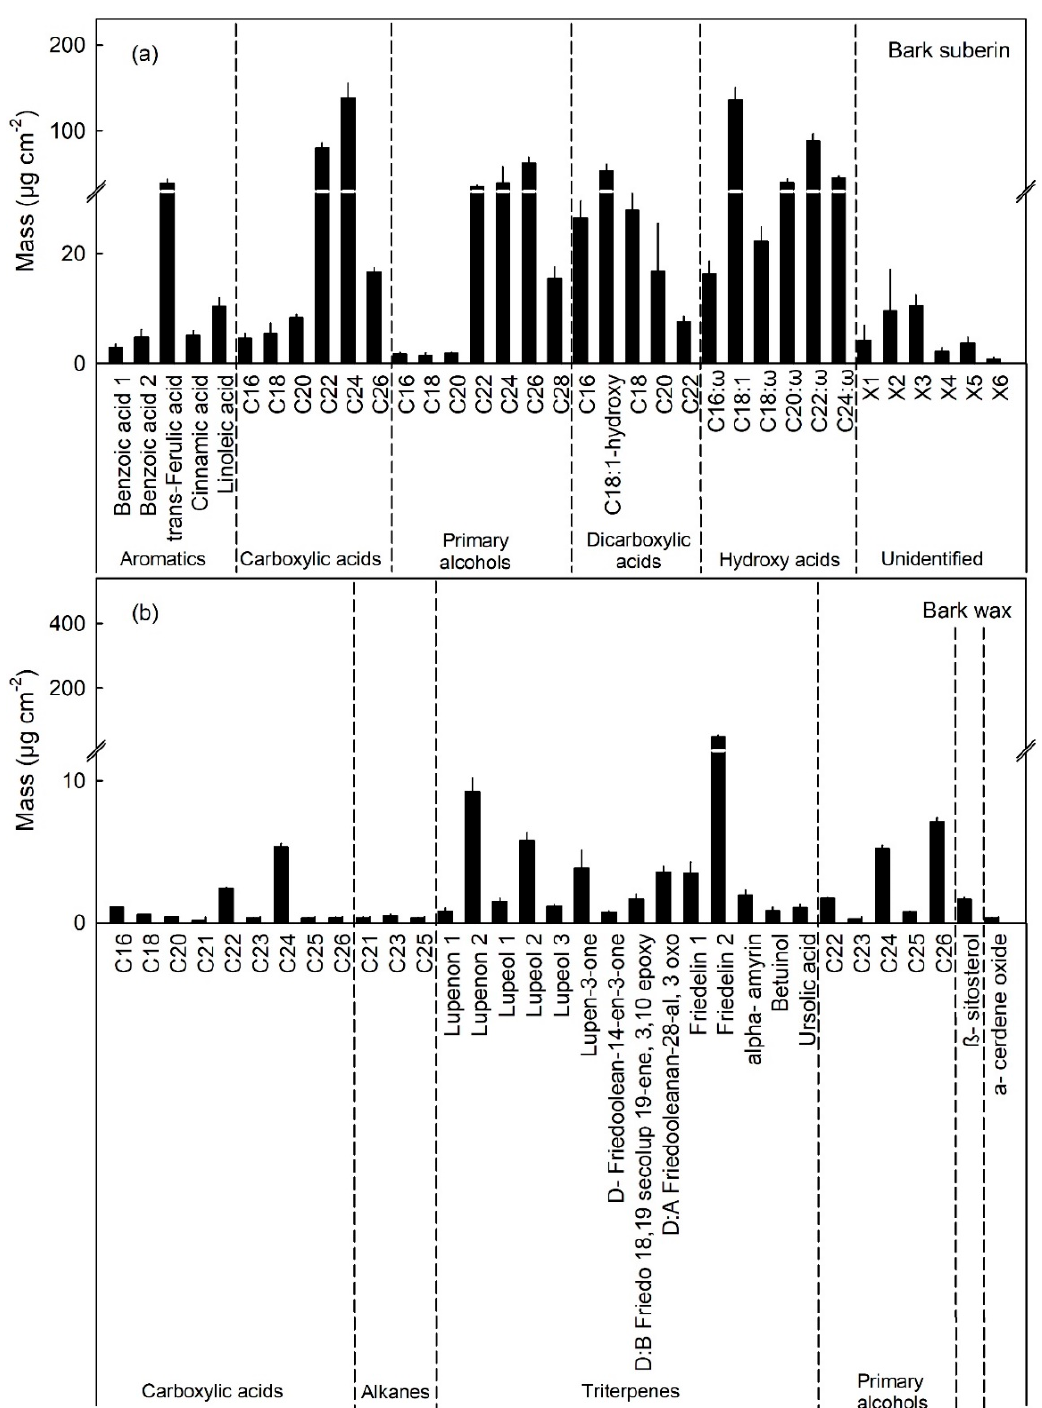
Figure 7. Composition of the periderm of the bark of the trunk (BP) of a ‘Pinova’ apple tree. ( a ) Constituents of the suberin and ( b ) constituents of the wax. The BP represents a pure periderm without any remnants of a cuticle.